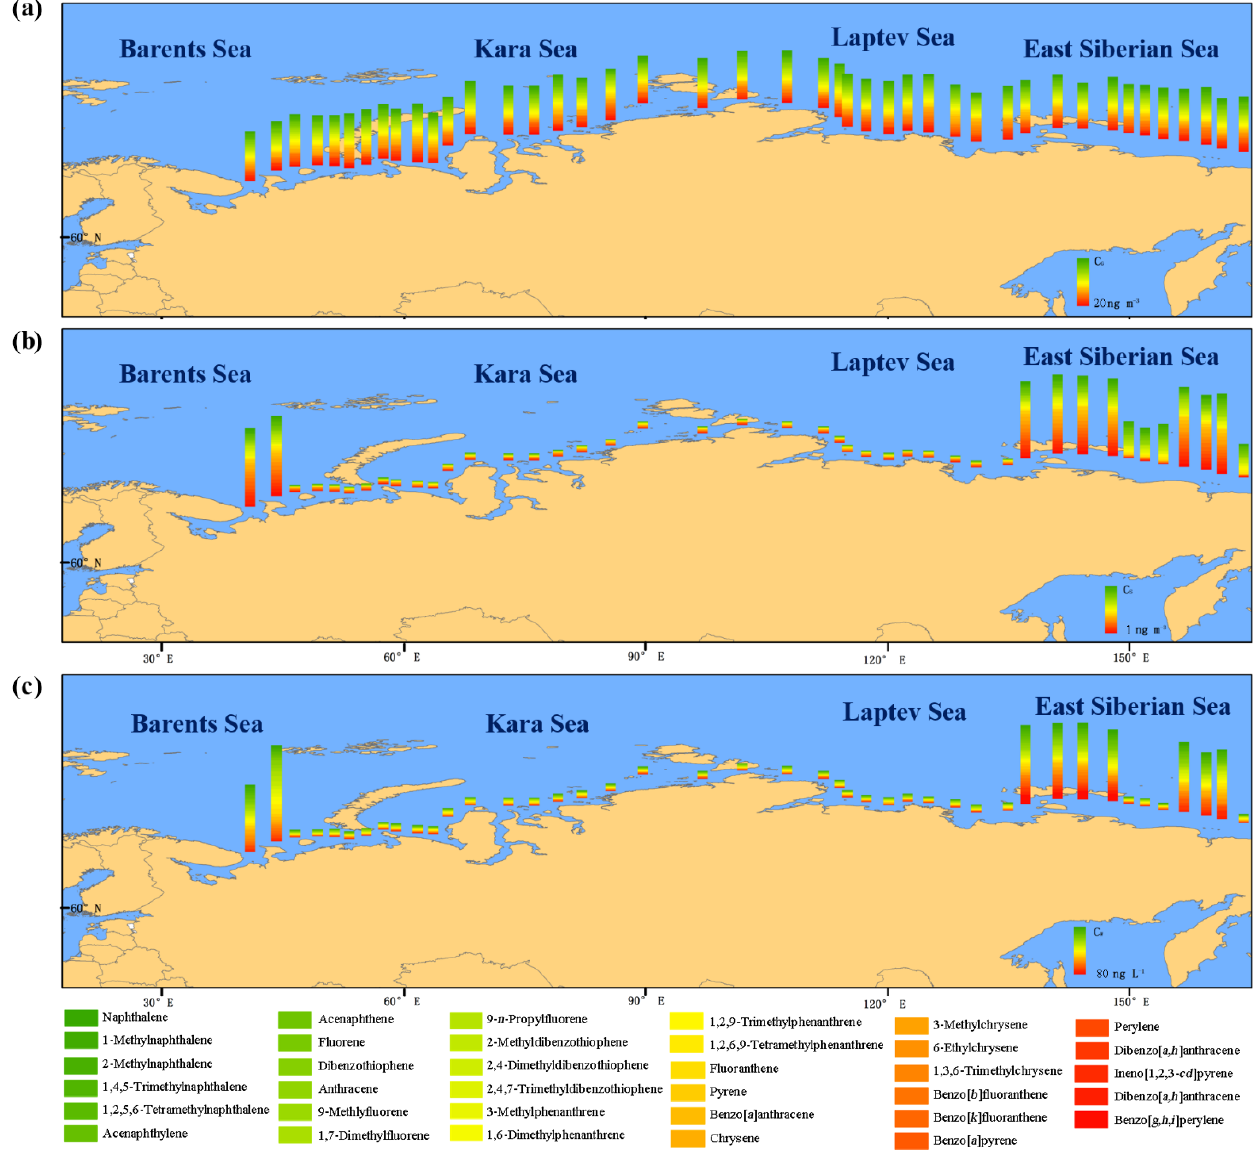
Figure 5. Occurrence of PAHs in the Russian Arctic Ocean. Concentrations of PAHs in the (a) gas phase, (b) aerosol phase, and (c) dissolved water phase. Color bars indicate the sum of 35 PAHs, where each PAH corresponds to the bottom legend (colors range from red for the heaviest molecular weight PAHs to green for the lightest molecular weight